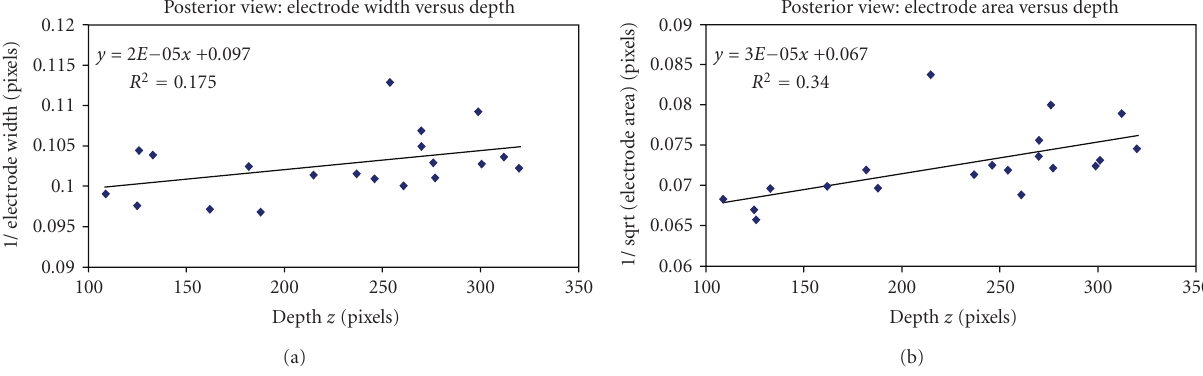
Posterior view: electrode width versus depth